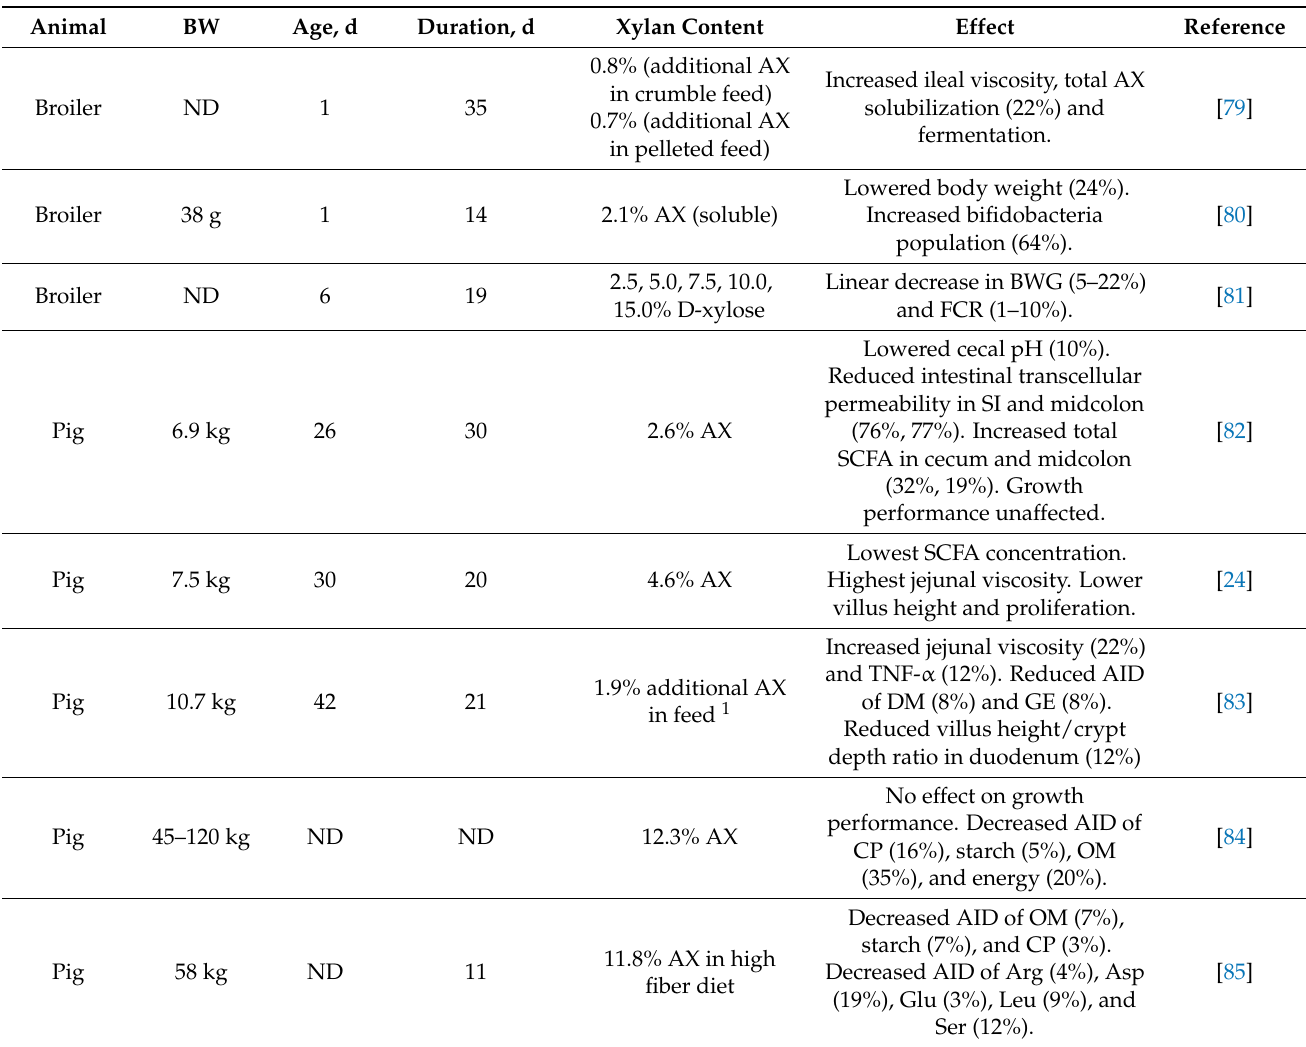
Table 2. Effects of dietary arabinoxylan content on monogastric animal